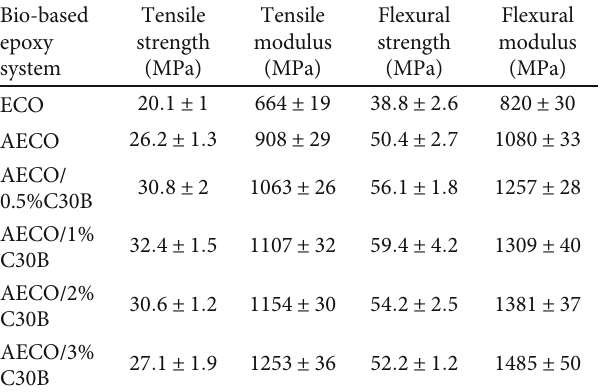
Figure 7: FTIR spectra of ECO and AECO (from Sudha et al. [52], adapted). Table 5: Mechanical properties of ECO and AECO and its nanocomposites [51].